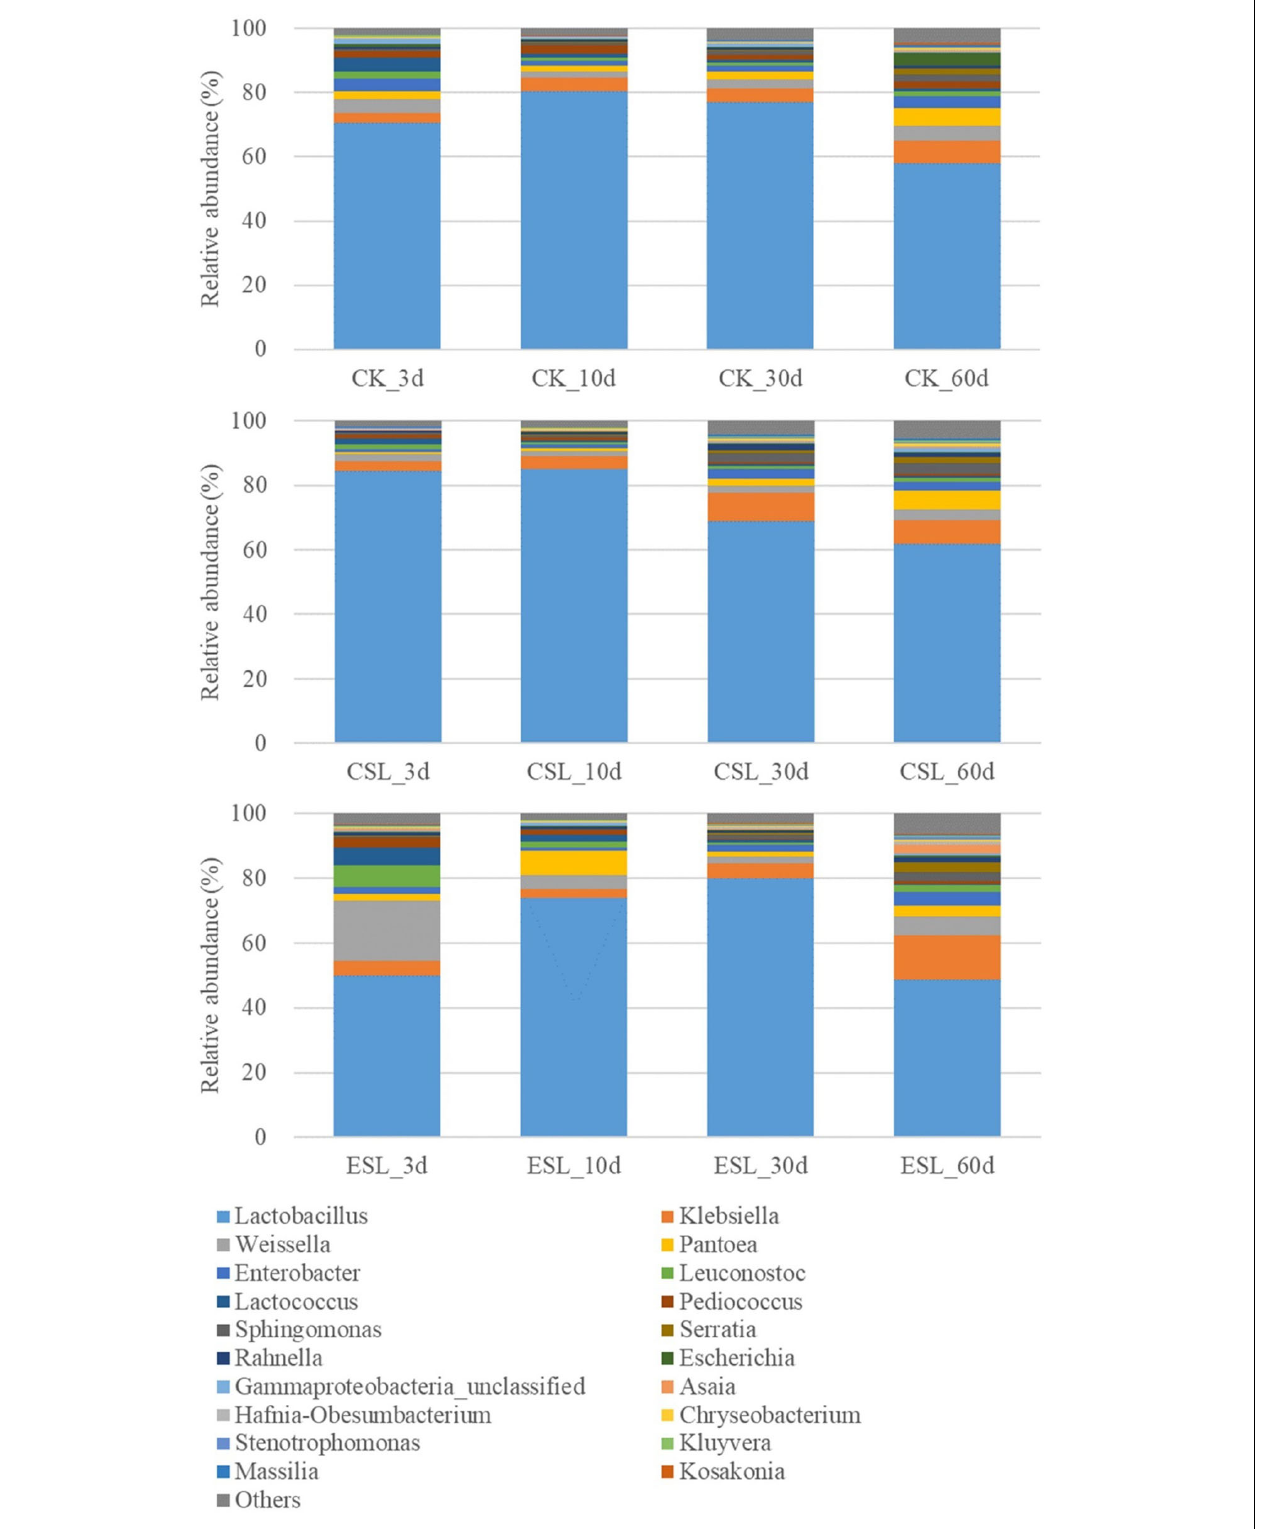
FIGURE 6 | Relative abundance of bacterial communities (genus level) in whole-plant corn silages during the stable phase. CK, whole-plant corn silage without any lactic acid bacterial suspensions; CSL, whole-plant corn silage treated with lactic acid bacterial suspensions prepared from whole-plant corn silage; ESL, whole-plant corn silage treated with lactic acid bacterial suspensions prepared from Elymus sibiricus silage.